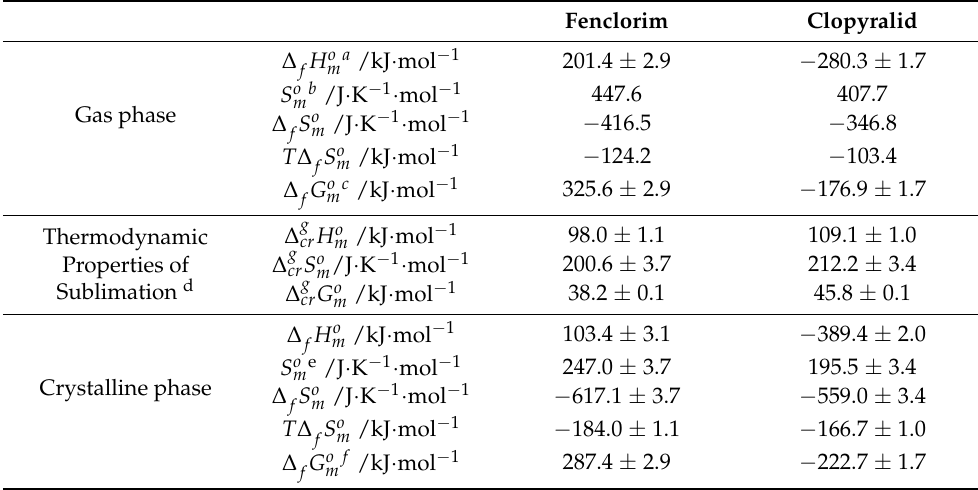
a The uncertainty assigned correspond to the expanded uncertainty determined from the estimated standard deviation of the mean (0.95 level of confidence) for the working reactions reported in SI (Tables S7 and S8), using k = 2.20 for fenclorim and k = 2.02 for clopyralid, respectively. b Obtained from G3(MP2)//B3LYP method for a frequency factor scale of 1.0029 [45]. c Calculated using Equation (4). d Derived through vapor pressure measurements. e Calculated from S o m ( 298.15 K, cr ) = S o m ( 298.15 K, g ) − ∆ g cr S o m ( 298.15 K ) . f Calculated from